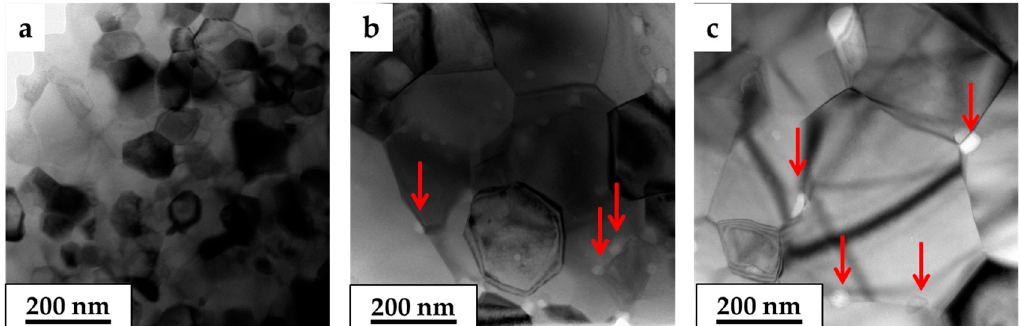
Figure 8. BF-TEM images of 0.20 at. % Li-MgO·1.21Al 2 O 3 spinel system as-processed ( a ); heat-treated at 1450 °C for 24 h ( b ); and heat-treated at 1450 °C for 72 h ( c ). Second phase in grain boundary, especially in triple points, is clearly visible in the heat-treated samples.